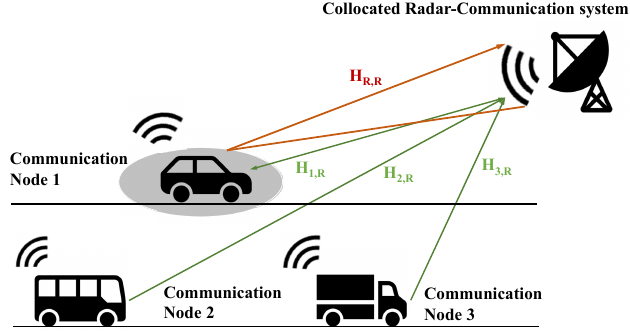
Figure 2. A practical vehicle networking example, in which the colocated radar-communication system coexists with a multiuser communication